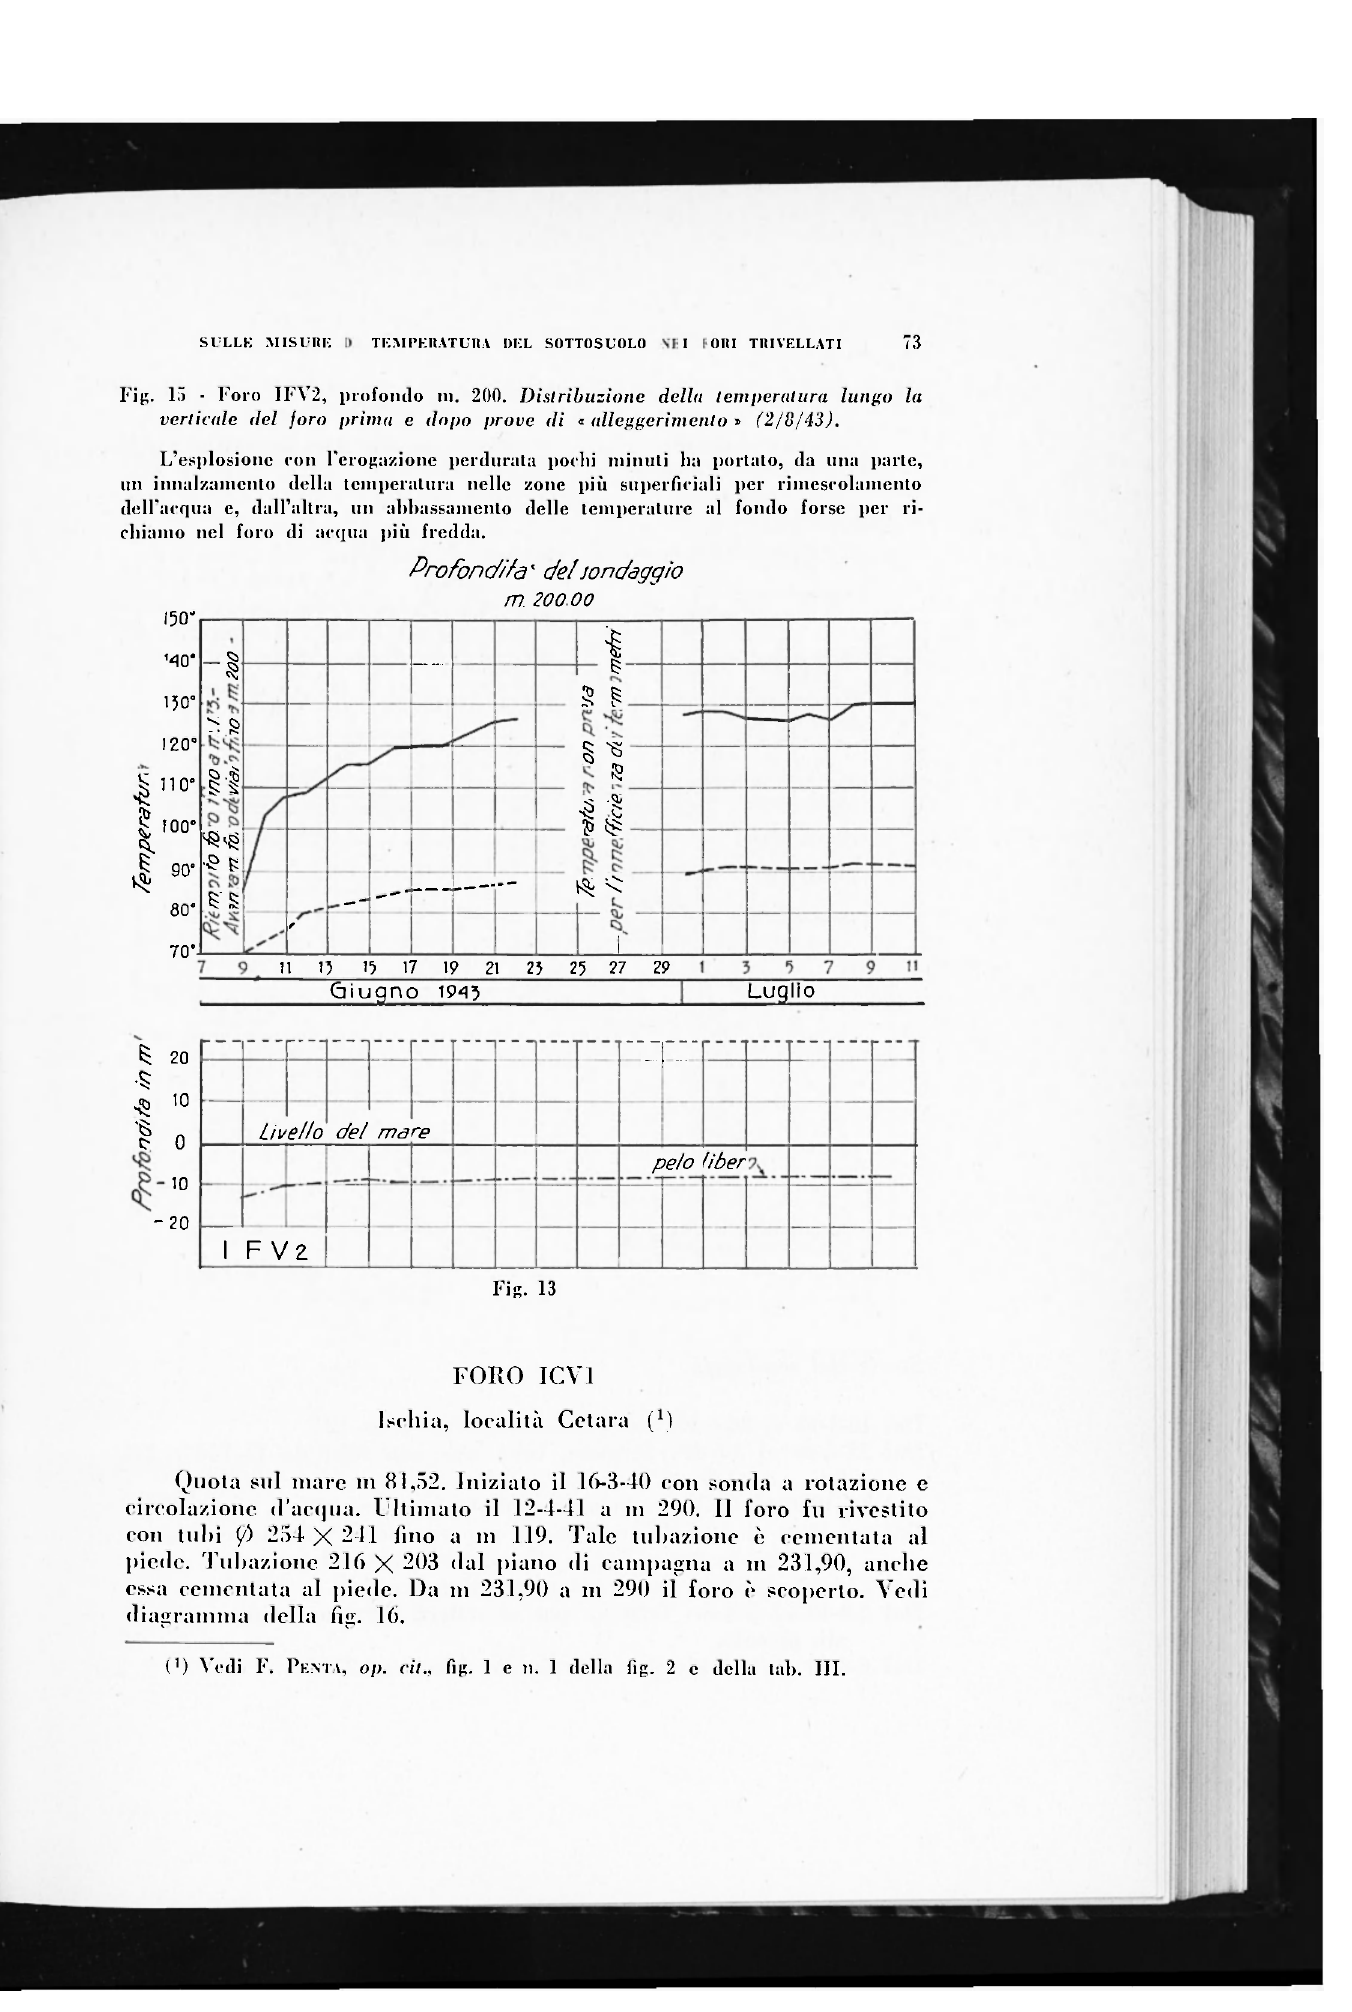
Fig. 15 - Foro IFV2, profondo ni. 200. Distribuzione della temperatura lungo la verticale del foro prima e dopo prove di <• alleggerimento » (2/8/43).